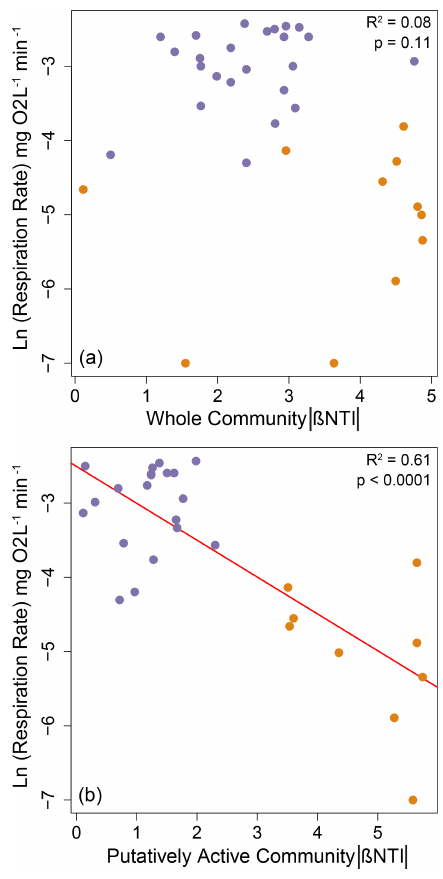
Figure 3. Natural-log-transformed respiration rates (i.e., O 2 con- sumption) as a function of the absolute value of β NTI for (a) whole communities or (b) putatively active communities. Larger absolute values of β NTI indicate stronger influences of deterministic assem- bly. Nonlinearity was observed because the respiration rate has a lower limit of 0 such that its relationship with β NTI was fit as a negative exponential function. The significant regression model is shown as a red line, and statistics are provided on each panel. Treat- ments with 0, 4, 8, or 27d dry are shown in purple. Treatments with 31 or 34d dry are shown in orange.